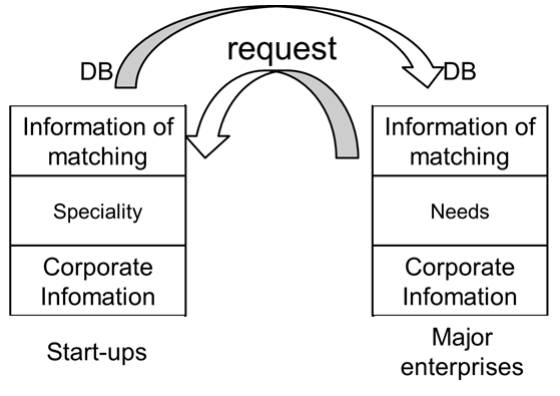
Figure 1. Flow of